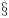
Summary of GenCAT discoveries in GWA meta-analysis data resources.*Number of genes detected by GenCAT that do not include a single SNP with a p-value less than the Bonferroni threshold of 5×10−8. **Number of genes/loci detected by GenCAT that are not within 500Kb of a gene that contains a single SNP with a p-value less than the Bonferroni threshold using the available GWA data. § Twenty-seven of 34 loci detected by GenCAT in CARDIoGRAM-2011 and GLGC-2010 were reported in follow-up analysis using minP with substantially more data [2–4]. These are therefore not novel findings given later publications, but highlight the ability of GenCAT to identify genes that are ultimately discoverable (“validated”) with minP when substantially larger datasets are interrogated.